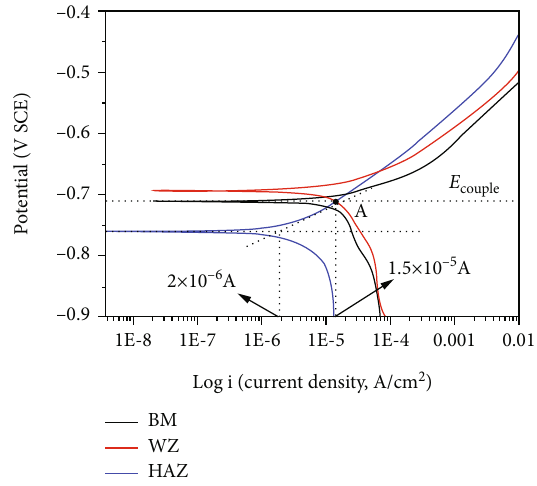
Figure 11: Quantization results of galvanic e ff ect between di ff erent areas of welded